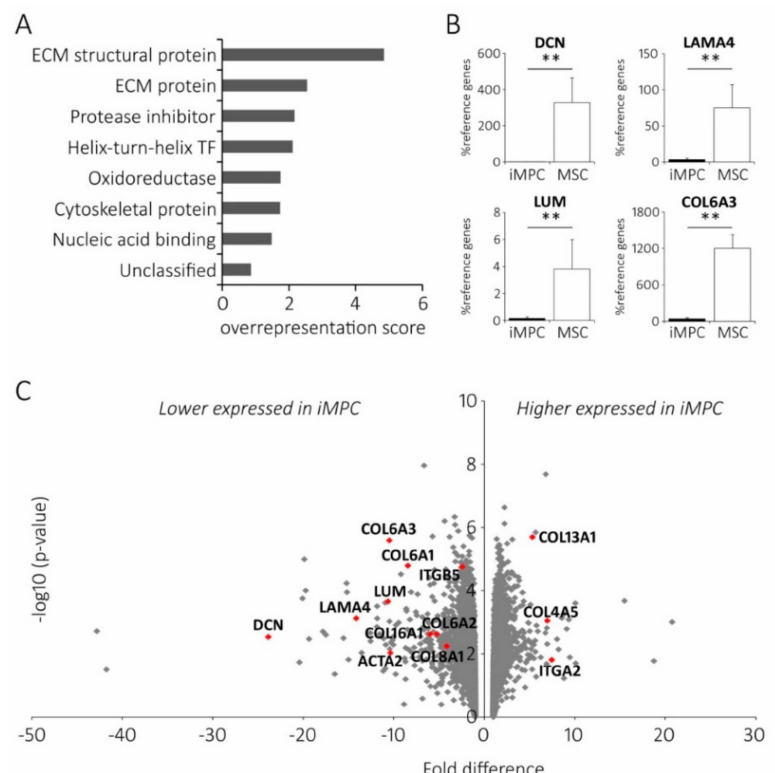
Figure 4. Di ff erential gene expression analysis between iMPCs and MSCs. ( A ) Genome profiling data were subjected to a Panther analysis, displaying statistical overrepresentation of the DEGs classified according to the protein class category. The binomial test and false discovery rate were used for statistics. ( B ) RNA from confluent passage 3 cells was extracted and cDNA was subjected to a qPCR analysis of selected ECM genes with the highest fold expression di ff erences. RPL13 , HPRT and CPSF6 served as housekeeping reference genes ( n = 6 independent iMPC [black bars] and MSC [white bars] donor populations; the mean ± standard deviation; ** p < 0.01 between groups, Mann-Whitney U-test). ( C ) The volcano plot depicting the fold di ff erences in gene expression plotted against the negative logarithm of the statistical significance of gene expression di ff erences (Student’s T-test) of all genes. The genes mentioned in the text are